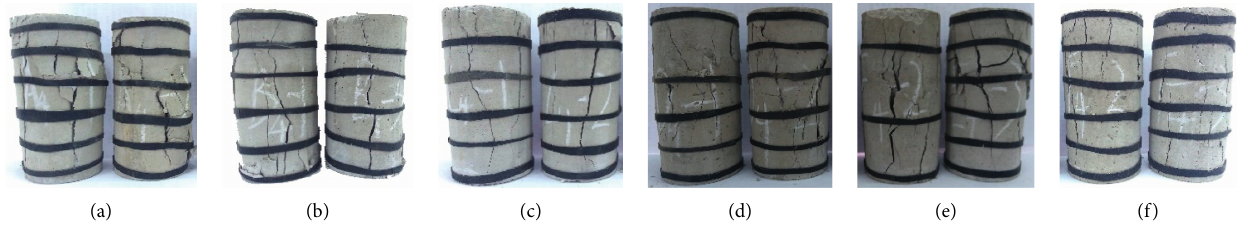
Figure 17: Failure mode of cement paste. (a) Group A. (b) Group B. (c) Group C. (d) Group D. (e) Group E. (f) Group F.